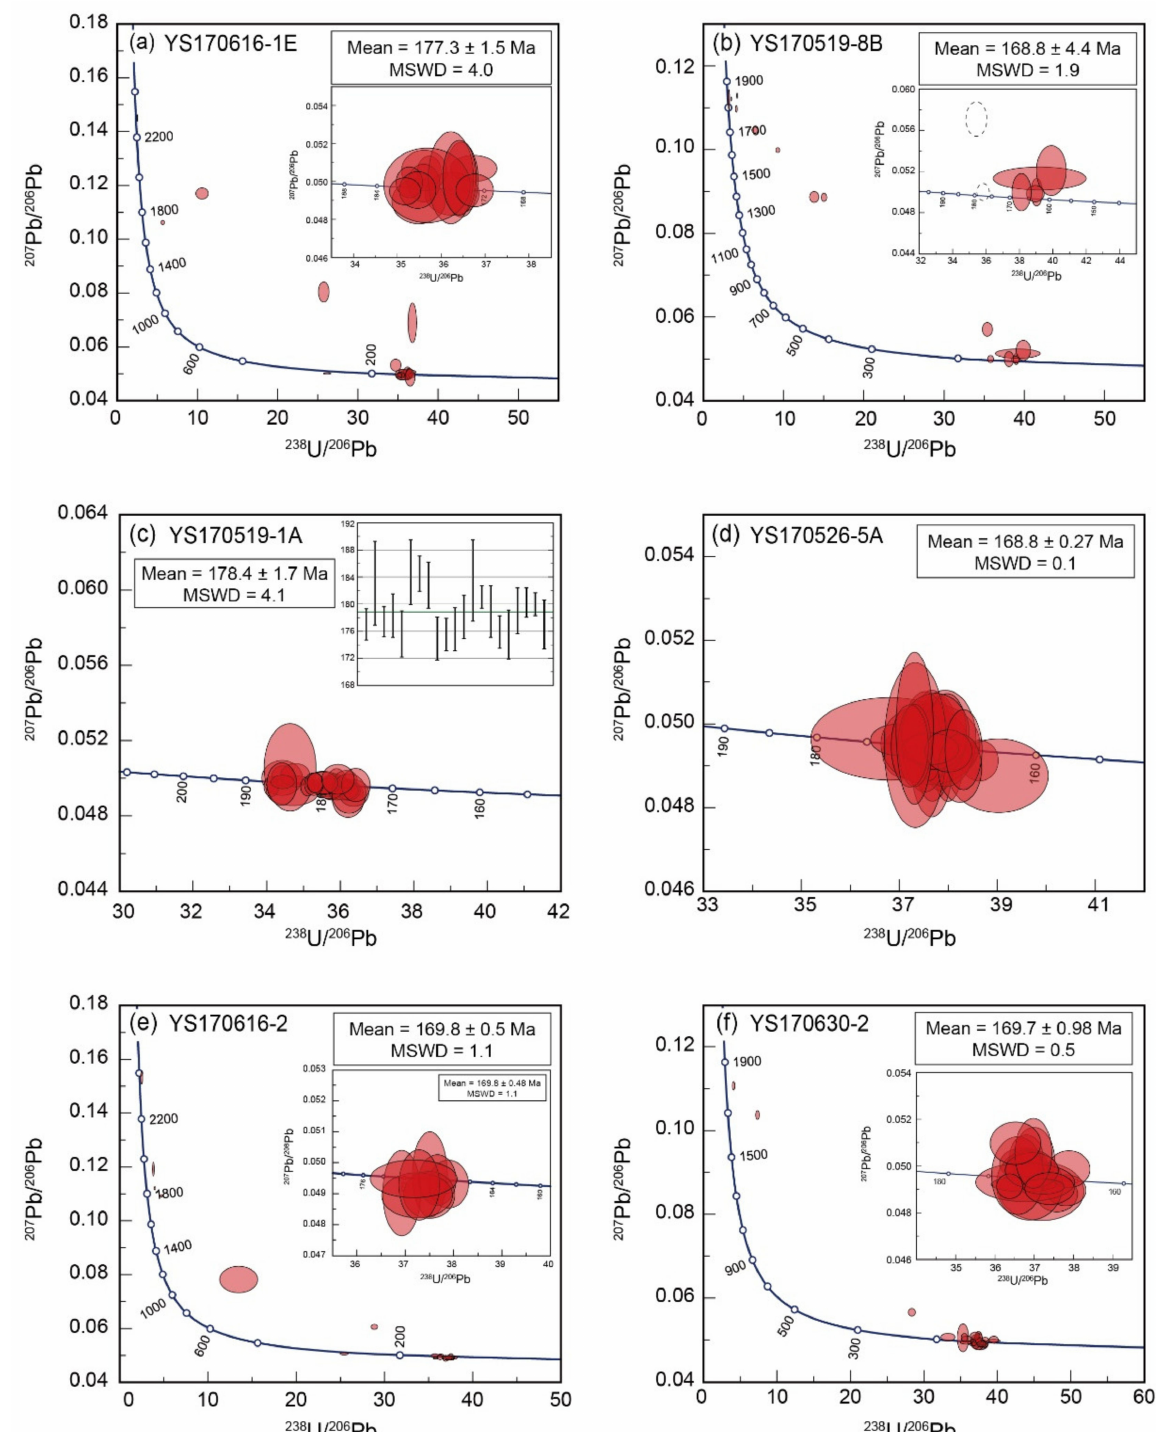
Figure 2. Zircon U–Pb concordia diagrams for ( a , b ) the Jurassic diorite, and ( c – f ) granitoids in the Yuseong